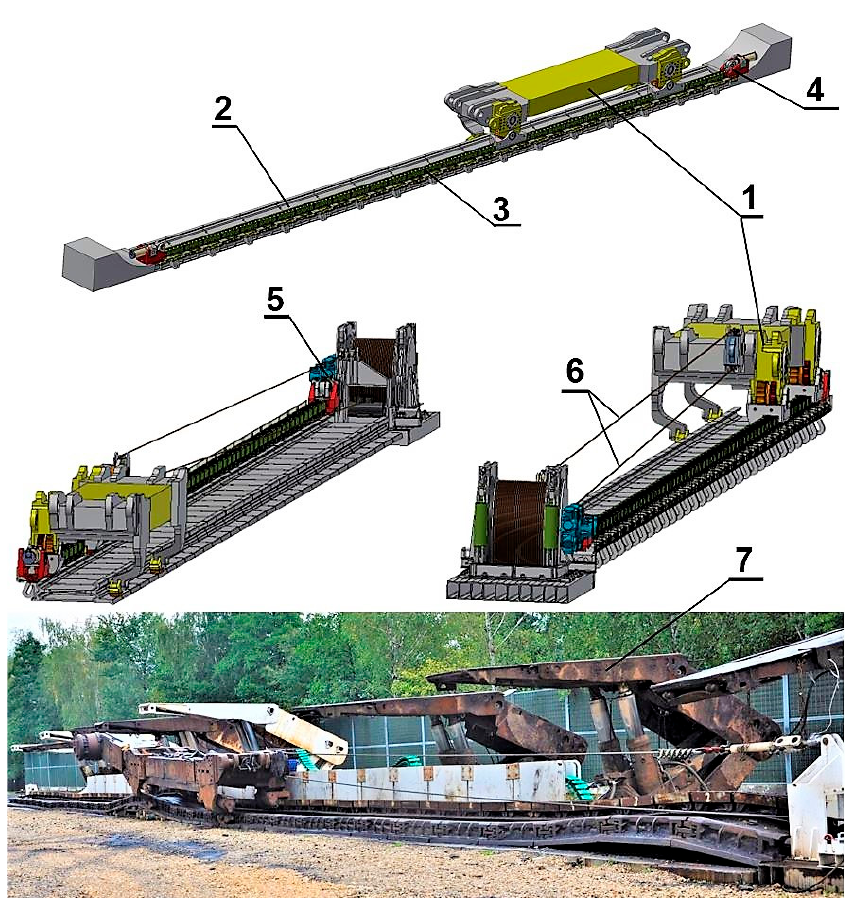
Figure 9. Three-dimensional model and a view of the field test rig for conducting functional tests of the Komtrack haulage system: 1—coal shearer, 2—armored face conveyor, 3—Komtrack haulage system, 4—tensioning system of toothed segments, 5—hydraulic winch, 6—braking rope, 7—powered roof supports.